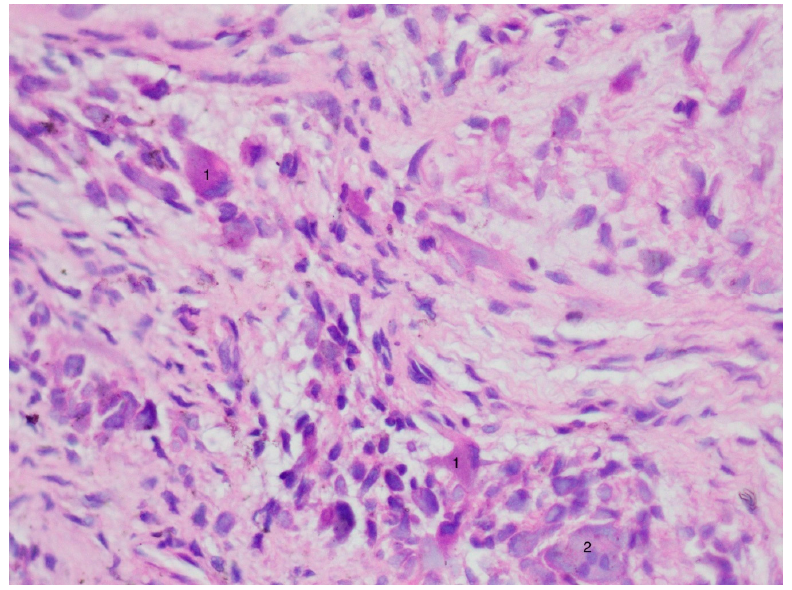
Figure 5. Postoperative material, H+E staining. High ‐ grade ‐ like areas are present with bizarre [1], multinucleated giant cells with abundant eosinophilic cytoplasm [2] (resembling myoid cells).